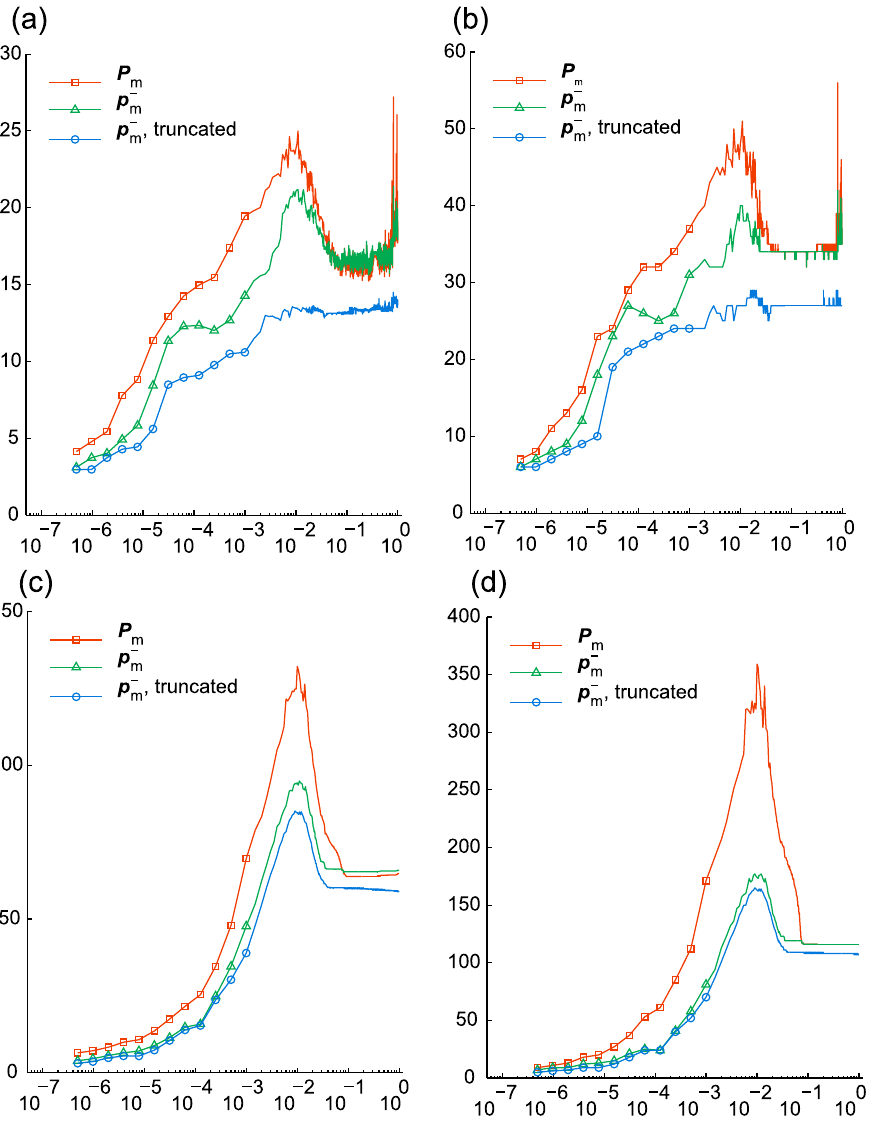
Figure 8. Enzymatic futile cycle. QTT ranks of the solution. The values are given vs. t m . Markers are omitted for t m § 2 : 10 { 3 . (a) Effective QTT ranks r eff for parameter set (A). (b) Maximum QTT ranks r max for parameter set (A). (c) Effective QTT ranks r eff for parameter set (D). (d) Maximum QTT ranks r max for parameter set (D). tensor network states : TT formatted tensors belong to the class of